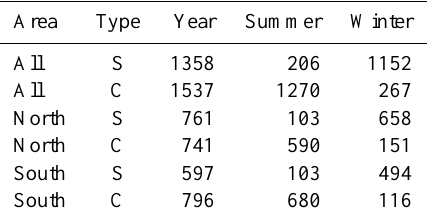
Table 2. Occurrence of convective and stratiform events. Number of quadrants of Germany classified as convective (C) or stratiform (S) in the 3 hourly synoptic observations. The maximum possible val- ues for the 2 years and for all four quadrants is 23360. This number reduces by about half for the seasonal data and again by half for the sub-regions of